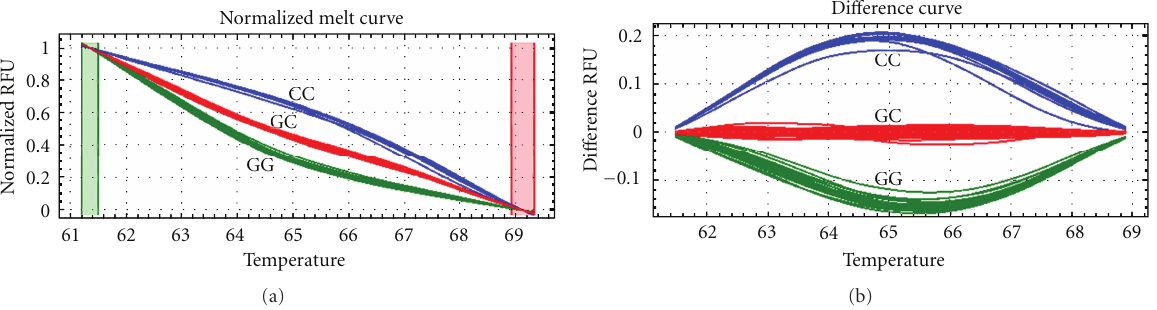
Figure 2: Normalized melting curves and di ff erence curves of unlabeled probe region for genotyping of SNP rs6887695. (a) The melting curve was presented after normalization. Wild type GG genotype showed the lowest melting temperature since there was completely mismatch between the unlabeled probe and wild type. (b) The di ff erence curves were obtained by subtracting each curve from one heterozygote (GC) curve. Three genotypes (GG, GC, and CC) were shown as